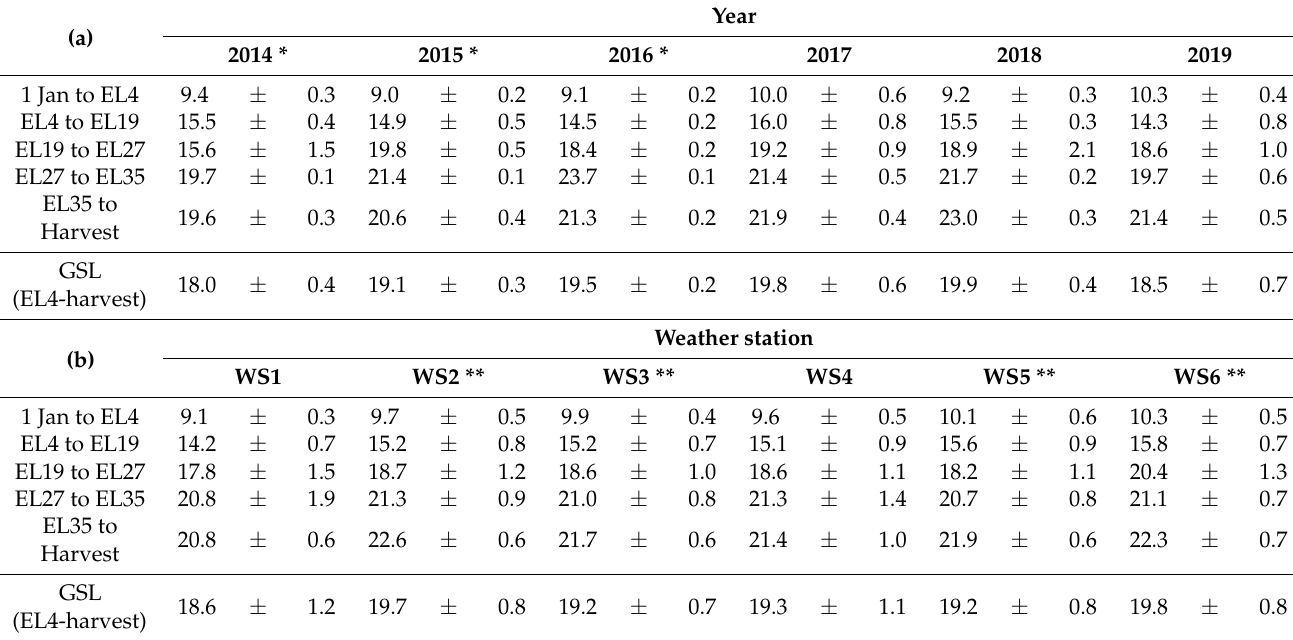
Table 1. Average and standard deviation of daily mean air temperature before budbreak (1 January to EL4), for the shoot and inflorescences development (E4 to EL19), flowering (EL19 to EL27), berry development (EL27 to EL35), and ripening (EL35 to harvest) phenophases, as well as for the growing season length, GSL (EL4 to harvest), recorded in each (a) year and (b) weather